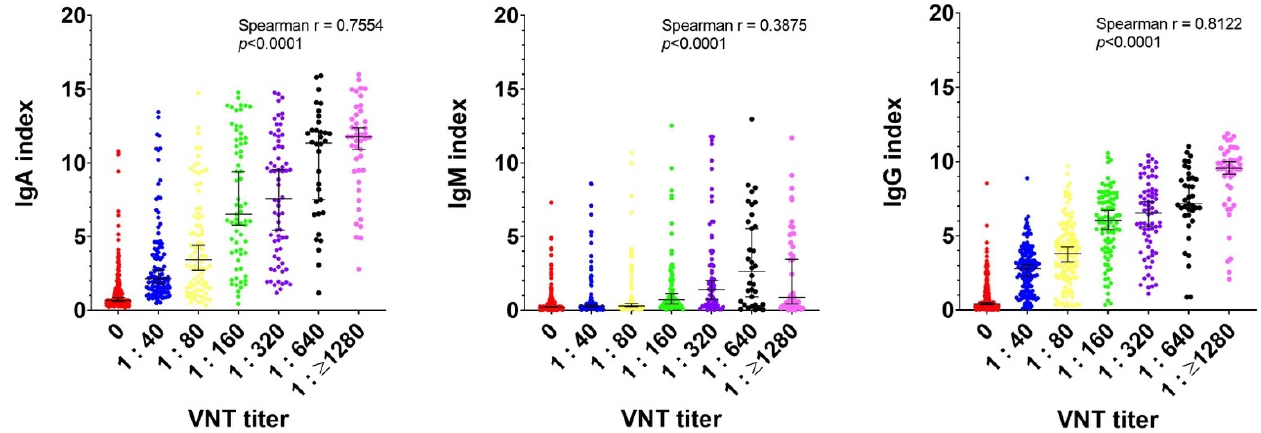
Figure 5. Correlation of the antibody levels and virus neutralization test. The Spearman’s rank correlation coefficient test shows a positive correlation of specific IgG antibody levels and VNT.